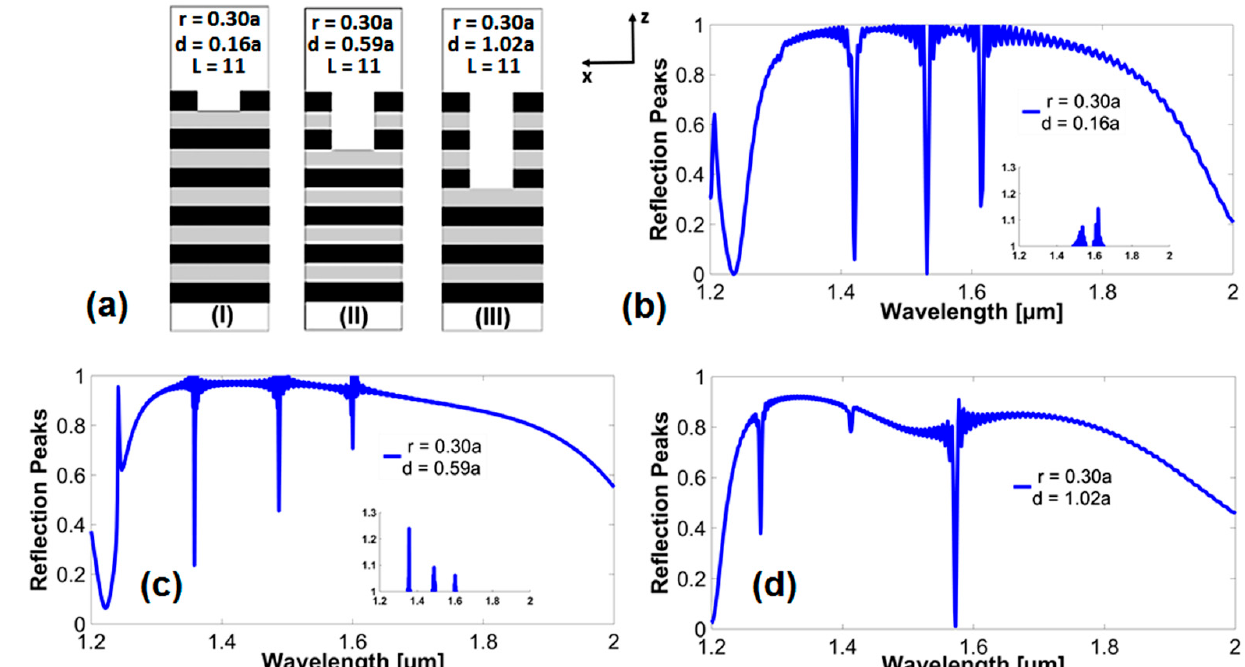
Figure 3. The reflection spectra of DBR structure with variation in the depth of the PhC holes. ( a ) DBR-PhC structure with PhC hole in (I) first layer, (II) third layer, and (III) fifth layer. ( b ) Depth of PhC holes reaching the first DBR layer. ( c ) Depth of PhC holes reaching the third DBR layer. ( d ) Depth of PhC holes reaching the fifth DBR layer.